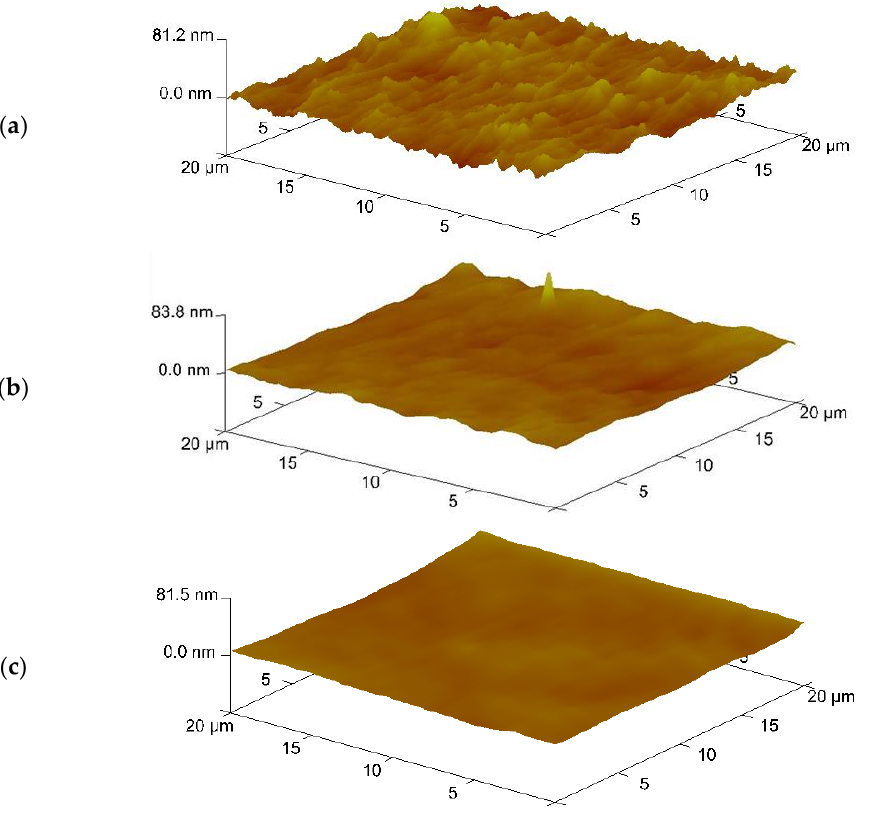
Figure 6. 3D topography analysis of samples. Six layers ( a ), eight layers ( b ), and 10 layers ( c ) using atomic force microscopy (AFM) over an area of 20 × 20 μm 2 .